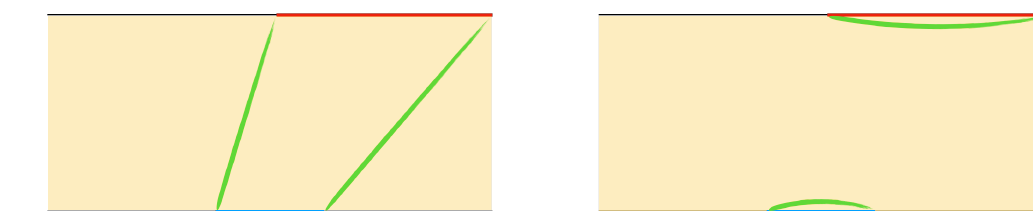
Figure 6: We show a projection of spacetime onto a single spatial dimension with time running vertically. To evaluate the Rényi entropies of A (blue line located at t = 0) and B (red line located at time t ), we find the candidate membranes (green lines). At early times, the membrane in the left figure will be minimal. It is clearly time-dependent because as time progresses, A and B are brought further away from one another. At late times, the membranes in the right figure will be minimal. These are clearly time-independent and represent the thermal